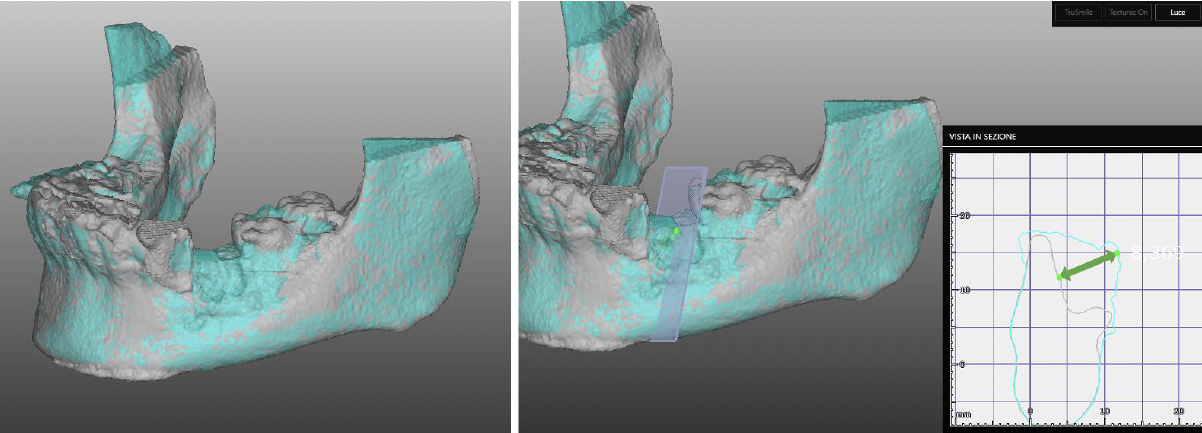
Figure 6. Segmentation of Dicom file and (T0 – T1) CBCT superimposition to evaluate horizontal, vertical and bone volume gains.